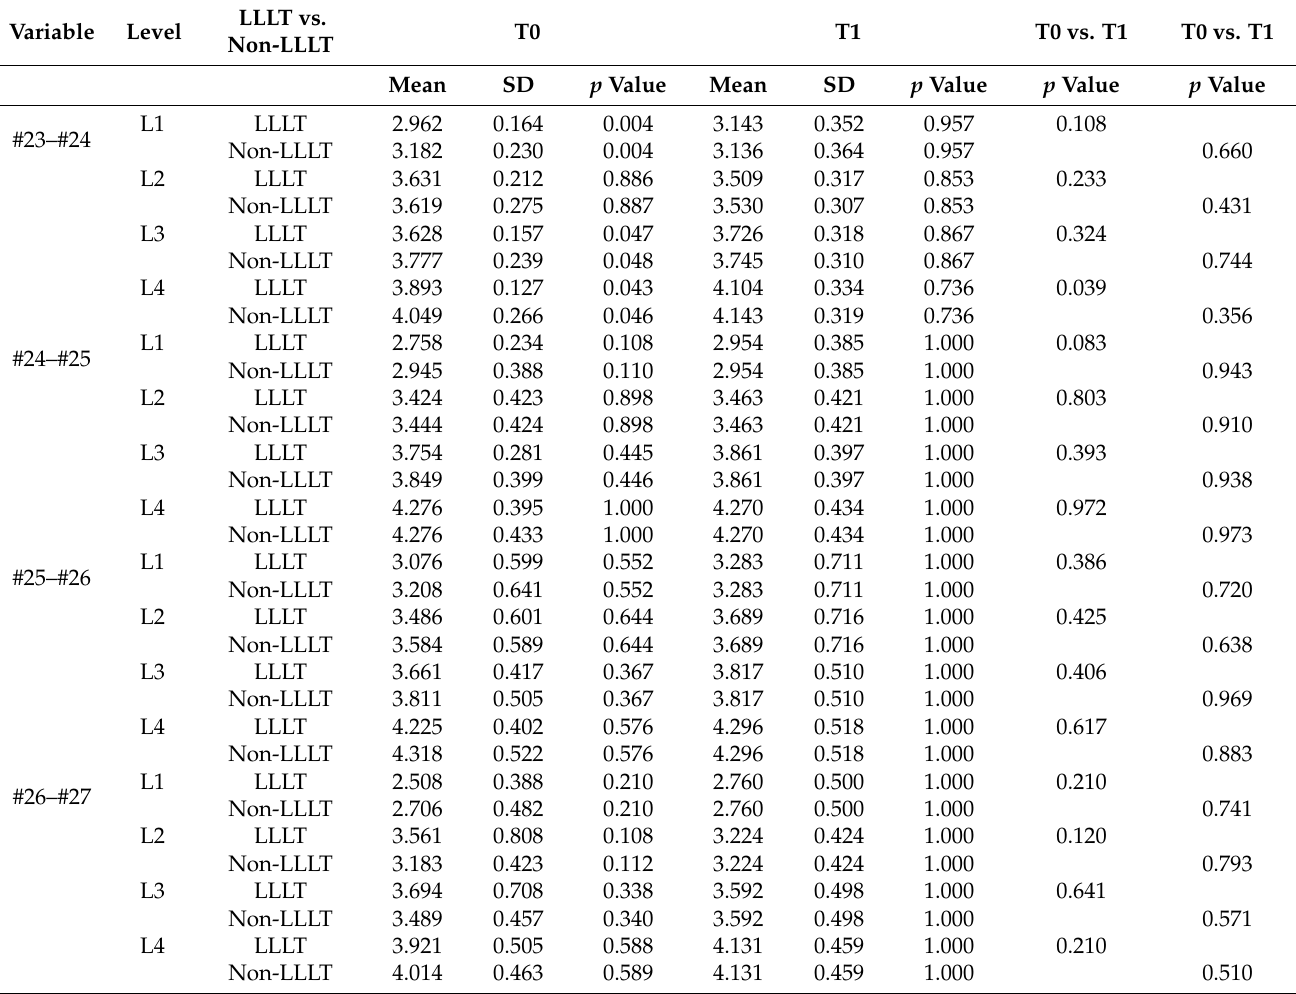
Table 4. IRW of the maxilla (both sides) at various levels. LLLT and non-LLLT differences among pre- and post-treatment groups—posterior left quadrant